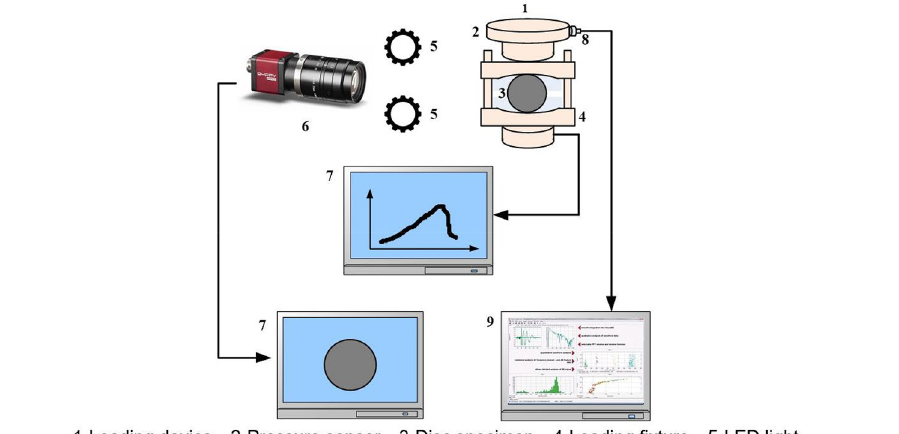
Figure 4. Digital speckle test